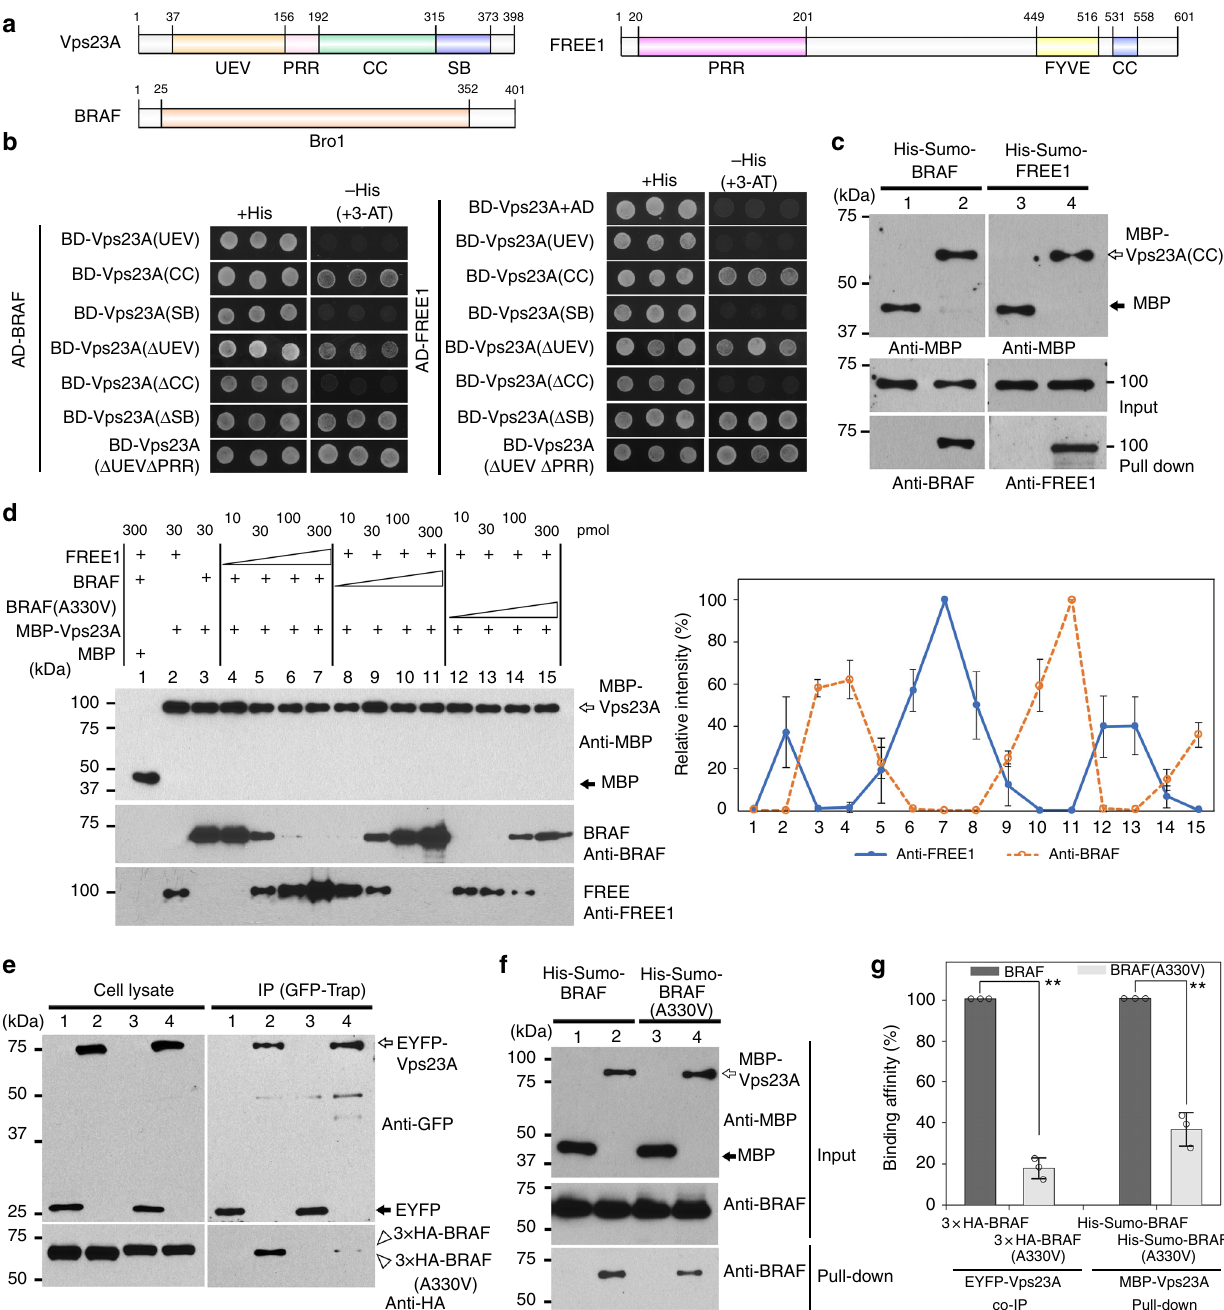
Fig. 4 BRAF competes with FREE1 for ESCRT-I component Vps23 binding. a Domain structures of BRAF, FREE1, and Vps23A. UEV ubiquitin E2 variant, PRR proline-rich region, CC coiled-coil, SB steadiness box. b Y2H analysis of the binary interactions between BRAF (left) or FREE1 (right) with different domain deletions of Vps23A. c In vitro binding assays of recombinant BRAF (lanes 1 and 2) or FREE1 (lanes 3 and 4) with MBP (lanes 1 and 3) and MBP-Vps23A (CC) (lanes 2 and 4). d Competition assay. Binding assay of MBP-Vps23A with 30 pmol of BRAF was performed in the presence of 10, 30, 100, or 300 pmol of FREE1. Binding assay of MBP-Vps23A with constant FREE1 was also performed in the increasing amounts of BRAF or BRAF(A330V). The pull-down ef fi ciency is shown on the right. The amount of proteins on the sepharose was compared with that of the control pair (as 100%) of MBP-Vps23A/FREE1 (lane 7) or MBP-Vps23A/BRAF (lane 11). The intensity of the pull down was normalized by the MBP-Vps23A intensity. Error bars are the S.D. from three independent experiments. e Immunoprecipitation (IP) analysis between 3 × HA-BRAF or 3 × HA-BRAF(A330V) and Vps23A. Arabidopsis protoplasts expressing EYFP (lanes 1 and 3) or EYFP-Vps23A (lanes 2 and 4) with 3 × HA-BRAF (lanes 1 and 2) or 3 × HA-BRAF(A330V) (lanes 3 and 4) were subjected to protein extraction, followed by immunoprecipitation (IP) using GFP-Trap agarose beads and subsequent immunoblot analysis on eluted proteins with indicated antibodies. f In vitro pull-down assays of BRAF or BRAF(A330V) with Vps23A. Recombinant His-Sumo-BRAF (lanes 1 and 2) or His-Sumo-BRAF(A330V) (lanes 3 and 4) was incubated with either MBP (lanes 1 and 3) or MBP-Vps23A (lanes 2 and 4) for 1 h at 4 °C and subjected to immunoblot analysis. g Quanti fi cation analysis of binding ef fi ciency in IP analysis and in vitro pull-down assays. The amount of binding protein in BRAF (A330V)-Vps23A was compared with that of the control pair of BRAF-Vps23A (as 100%). The intensity of the immunoblot was normalized by the input. Error bars represent the S.D. from three independent immunoblot results. ** P < 0.01 in Student ’ s t